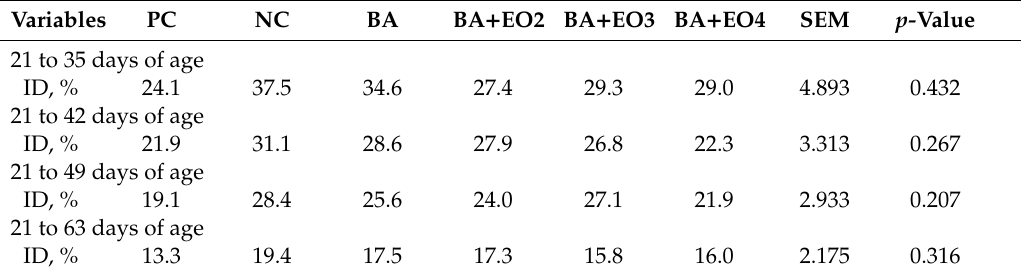
Table 3. E ff ect of experimental diets on the incidence of diarrhea in piglets challenged with E. coli F4. Variables